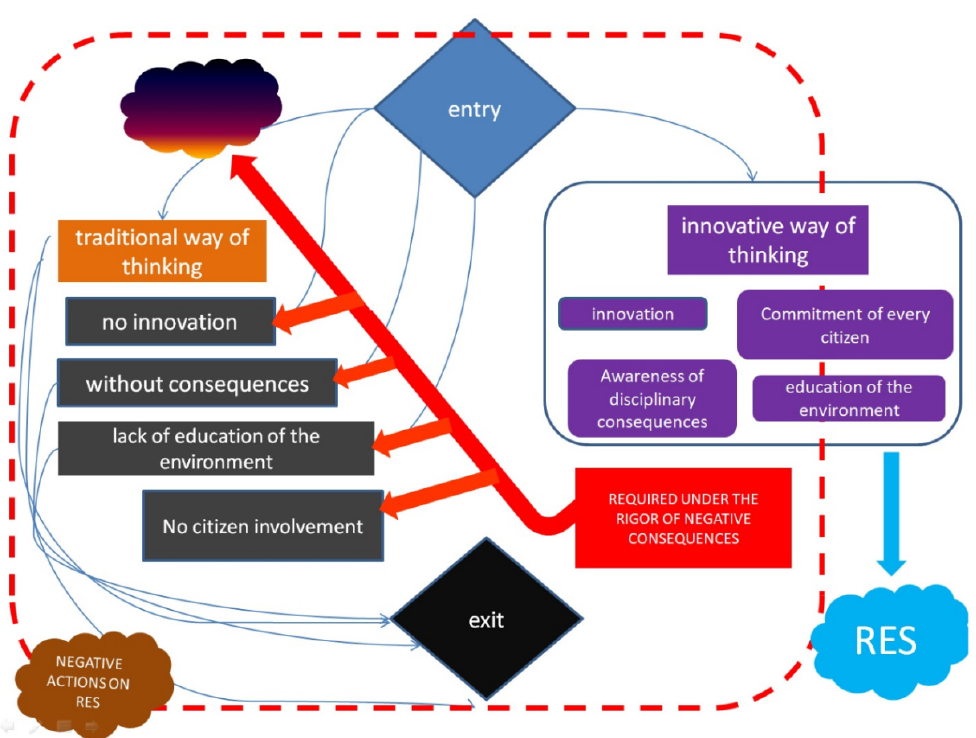
Figure 32. Descriptive model implementing an innovative way of